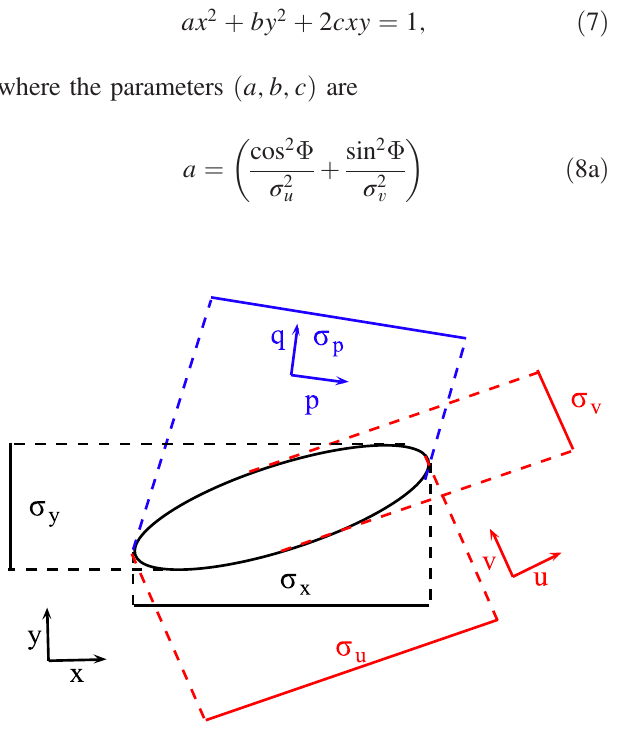
FIG. 8. General tilted ellipse: ð x; y Þ is the laboratory reference system (in black), ð u; v Þ refers to the reference system in which the ellipse is not tilted (in red), while ð p; q Þ refers to the one rotated by an angle θ with respect to the laboratory system (in